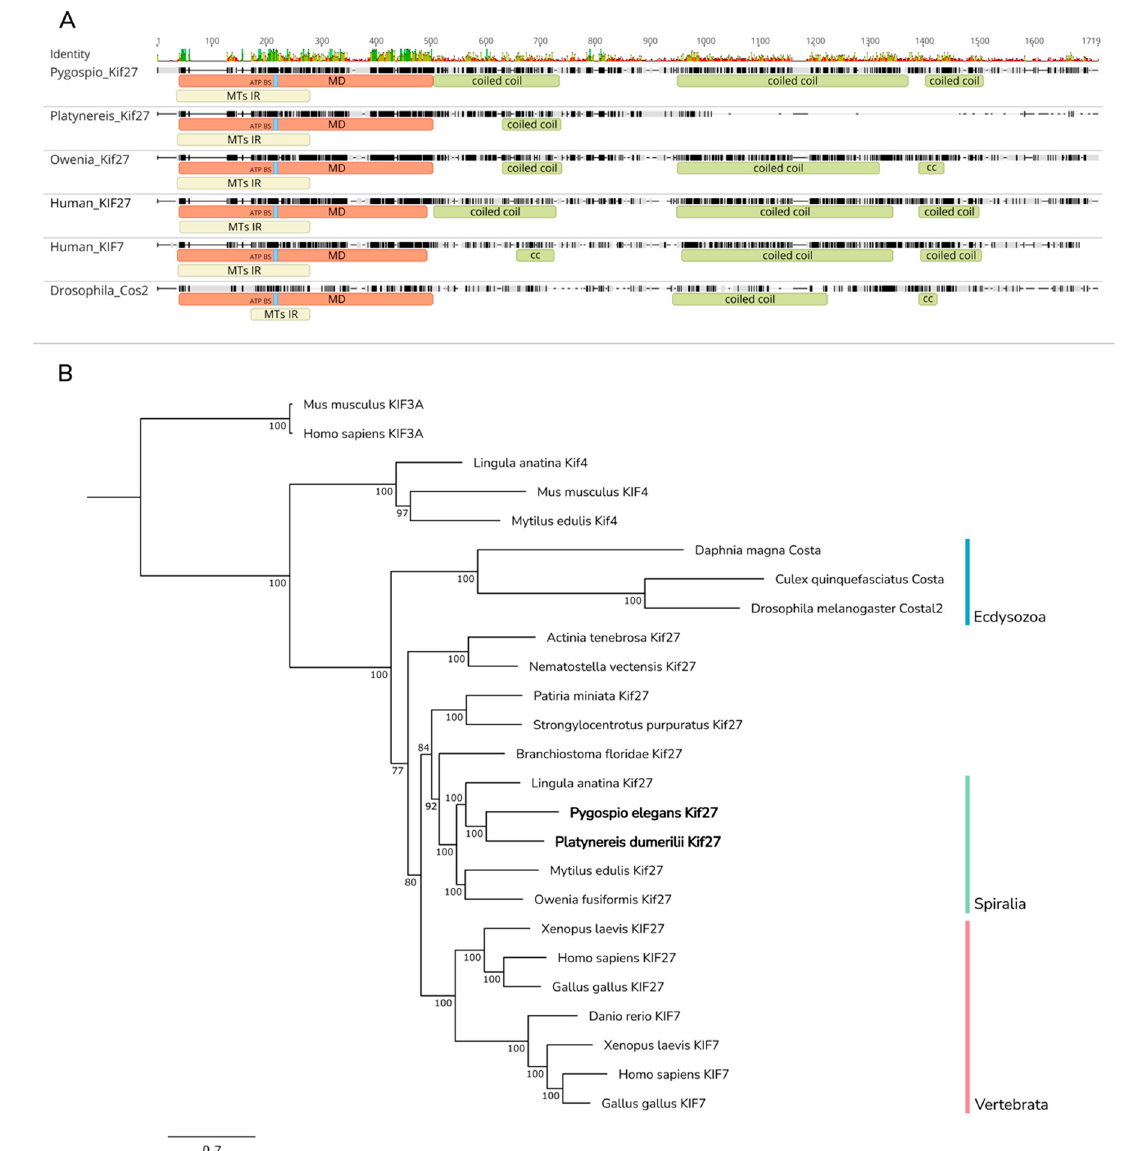
Figure 8. Multiple sequence alignment and phylogenetic analysis of Kif/Cos proteins. ( A ) Kif7 and Kif27 are members of the kinesin superfamily of motor proteins (Kifs) that move along microtubules (MTs) in an ATP-dependent manner. Among metazoan Kif proteins, the structure of human KIF7 and KIF27 is the best studied. Human KIF7 and KIF27 possess an N-terminal globular motor domain that contains an ATP-binding site and MT-interacting region, followed by a stalk domain predicted to form a discontinuous coiled coil. In Pygospio and Platynereis transcriptomes, we found only Kif27 orthologs that share a similar domain composition with human KIF proteins. MD, motor domain; MT IR, MT-interacting region; ATP BS, ATP-binding site. ( B ) For phylogenetic analysis, full-length amino acid sequence alignment was taken. Homologs of KIF27 are not found in fish lineages, while tetrapods possess both proteins. In Pygospio , Platynereis , and other spiralian species, we found orthologs of KIF27 and no obvious homologs of KIF7. Vertebrate KIFs fell into one clade with spiralian Kif27, while ecdysozoan Cos proteins formed a basal branch on the tree. Numbers near branch nodes indicate Bayesian posterior probabilities. Bayesian posterior probability values less than 75 are not shown.